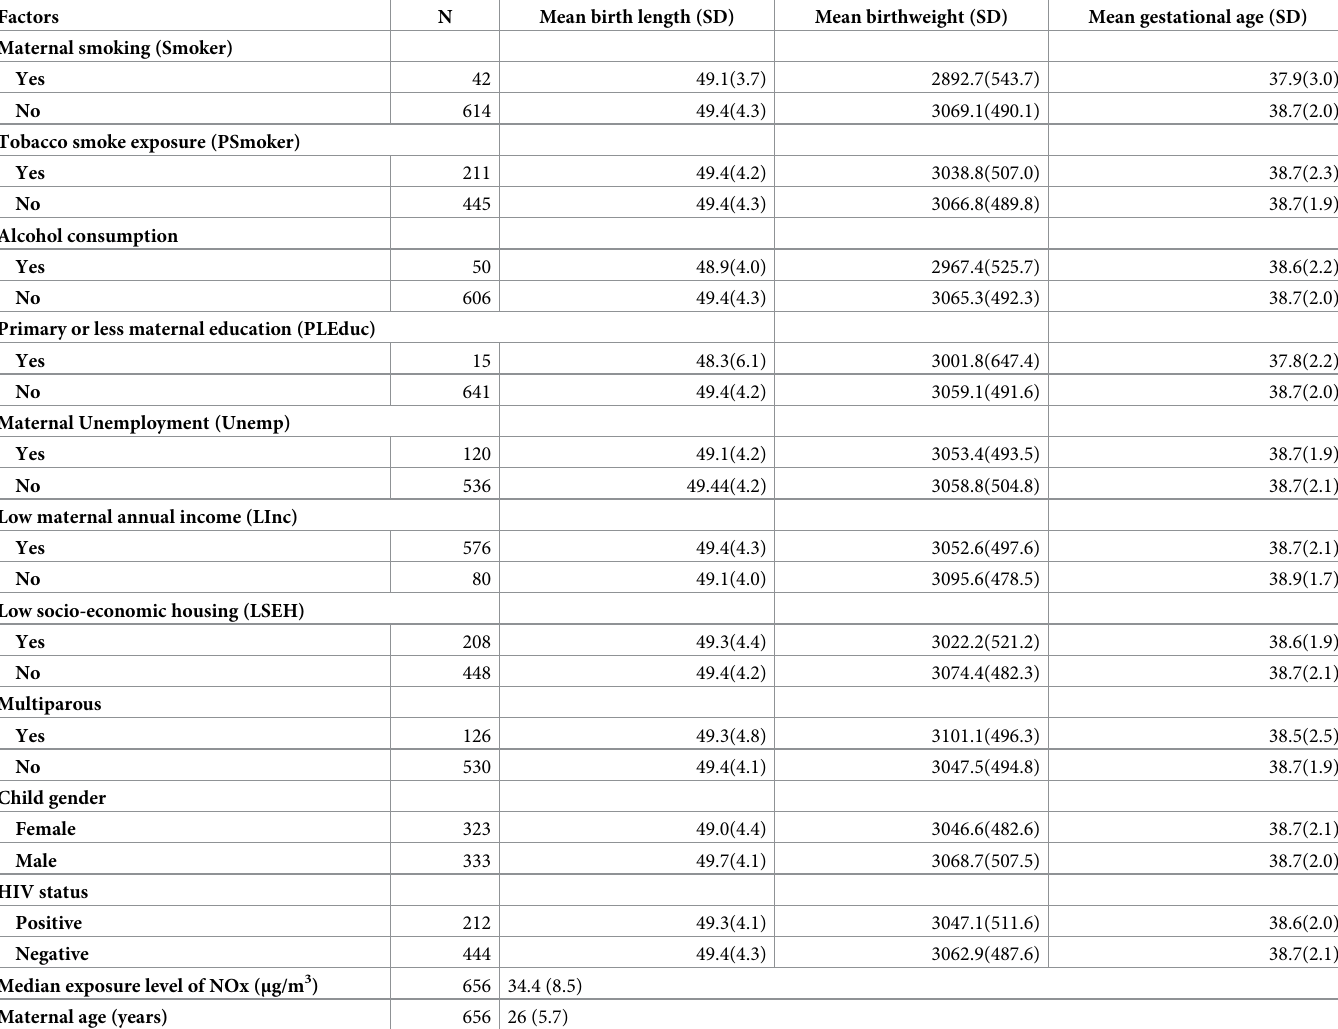
Table 1. The birth outcome measures summary statistics by prenatal exposure